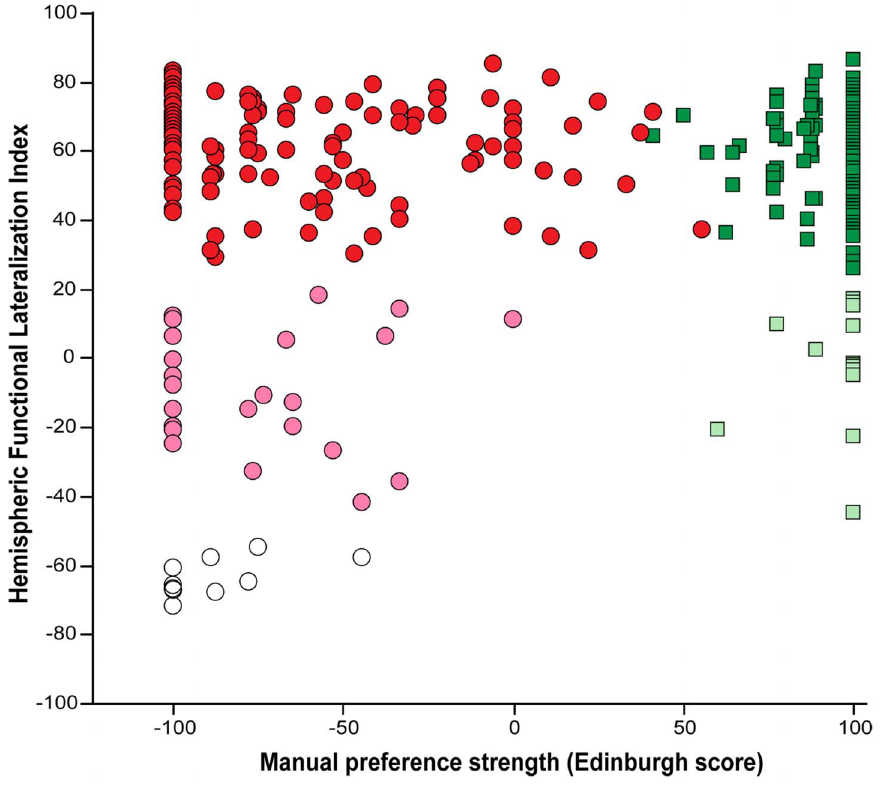
Figure 5. Plot of hemispheric functional lateralization for language as a function of manual preference strength. Manual preference strength was assessed using the Edinburgh inventory, ranging from 100 (exclusive use of the right hand) to 2 100 (exclusive use of the left hand). Subjects also self-reported whether they consider themselves as right- handed (RH, squares) or left-handed (LH, circles). HFLI, an index of hemispheric functional lateralization for language measured with fMRI during covert generation of sentences compared to covert generation of list of words, was used for classifying subjects as « Typical » (HFLI . 50, bright color symbols), « Ambilateral» ( 2 20 , HFLI , 50, pale color symbols), or « Strongly-atypical » (HFLI ,2 20, open